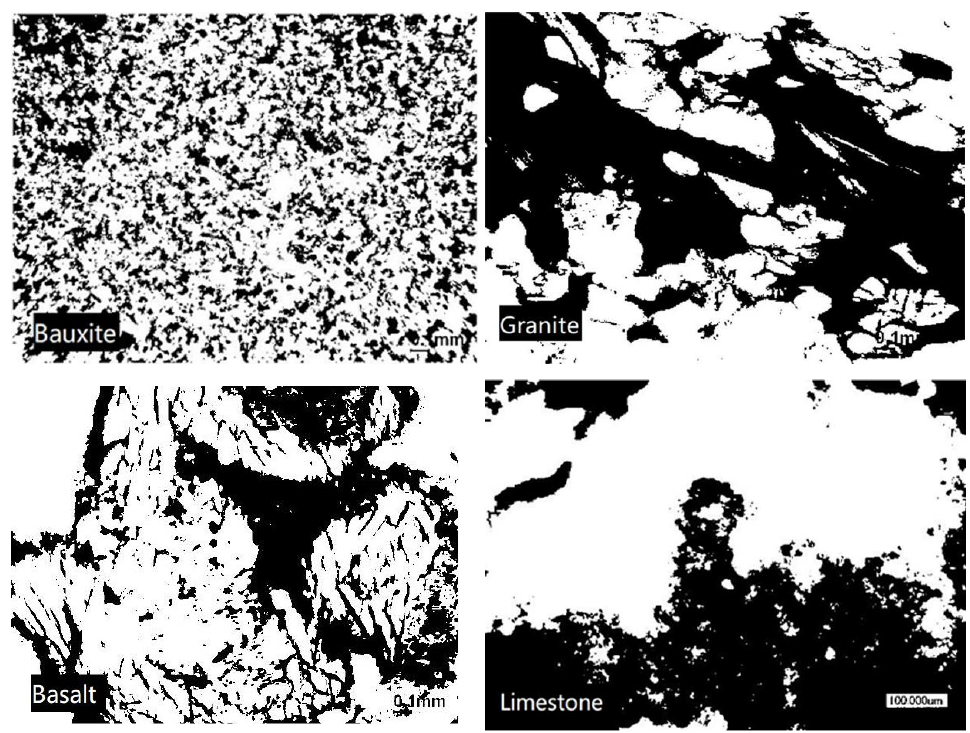
Figure 3. Binarization images of the four aggregates, derived from the laser microscope images in Figure 2. Table 2. Fractal box dimension D of the four aggregates. Calcined Bauxite Granite Basalt Limestone Fractal box dimension ( D ) 2.0454 1.9699 2.002 1.9562